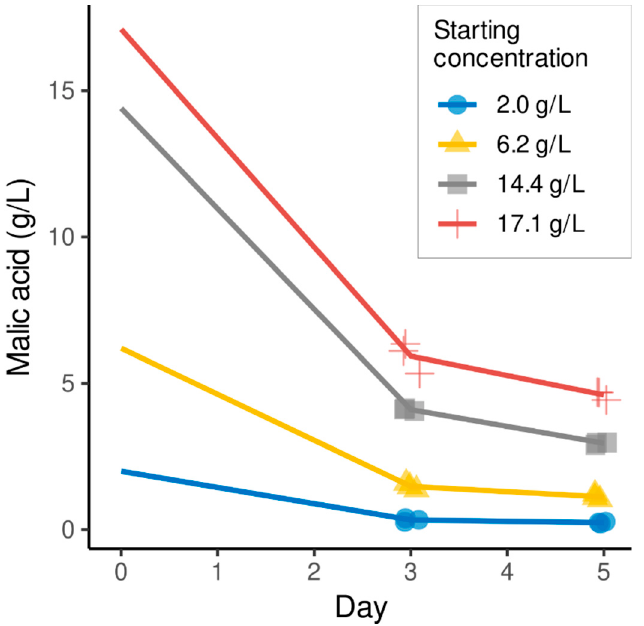
Figure 2. Short Muscaris must fermentations inoculated with H. occidentalis containing additions of malic acid. Malic acid concentrations were determined after three and five days of incubation.